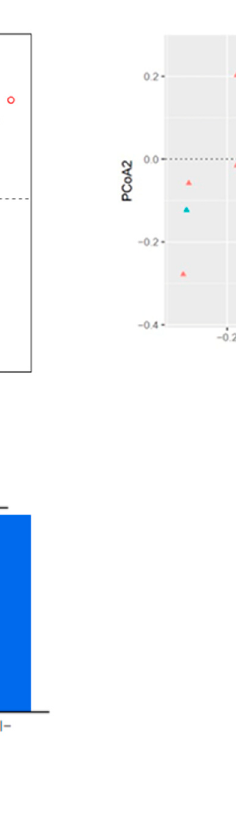
Figure 2. Diversity indices for fungal and bacterial microbiome composition in control and PE pregnancies, based on ITS and 16S sequencing. Beta diversity illustrated with principal coordinate analysis (PCoA) for fungal ( a ) and bacterial microbiota ( b ). Vectors indicate increasing BMI and gestational age. ( c ) The two bar plots quantitatively depict how BMI and gestational age influence the differences between the two groups BMI+ and BMI-, separated in the PCoA plot for fungal microbiota ( a ). C: control, PE: preeclampsia, l.o: lacto-ovo vegetarian, omn: omnivorous, veg: vegan diet. t -test for significance. * p = 0.0361.